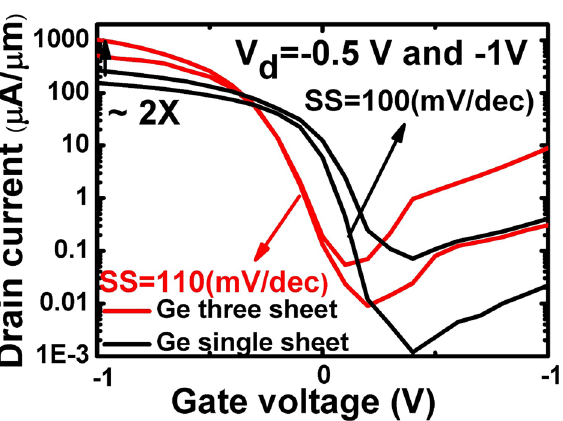
Vg curves of a three stacked Ge nanosheet n-FET device.